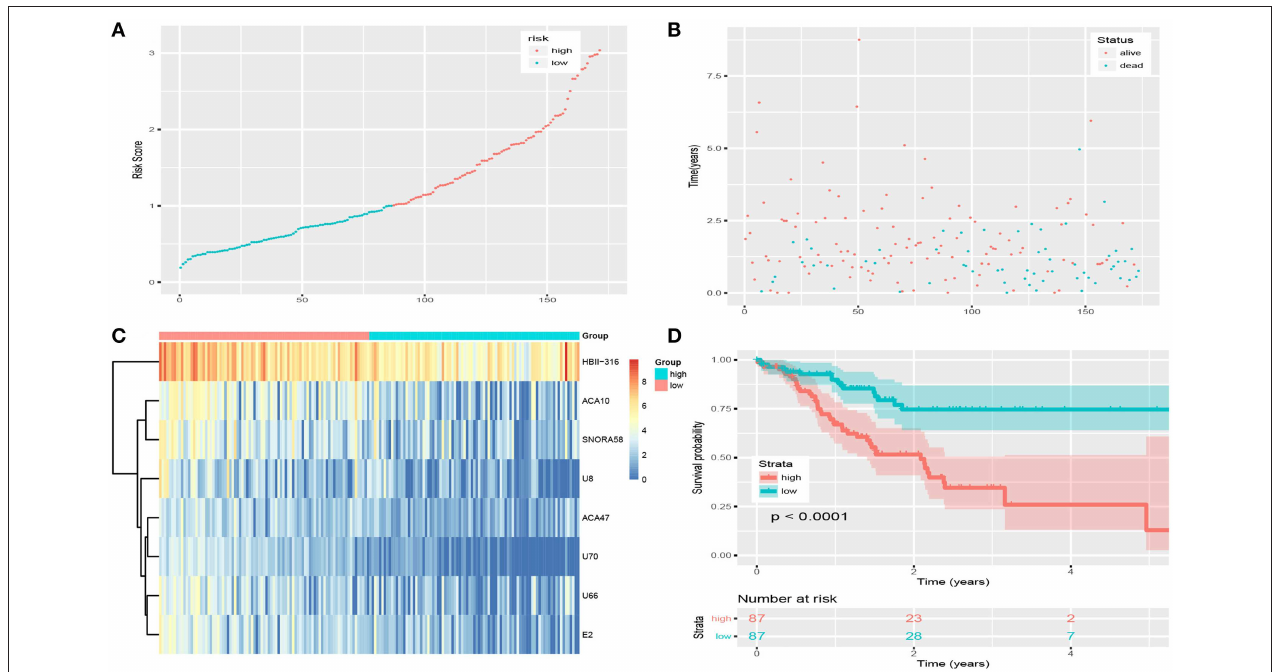
FIGURE 2 | Risk score of snoRNAs-based signature in training set. (A) The risk score of patients in train set based on risk signature. (B) The distribution of patients’ survival status and time. (C) The expression profile of eight snoRNAs in train set. (D) Survival curve of low-risk group and high-risk group based on median risk score via Kaplan-Meier method.